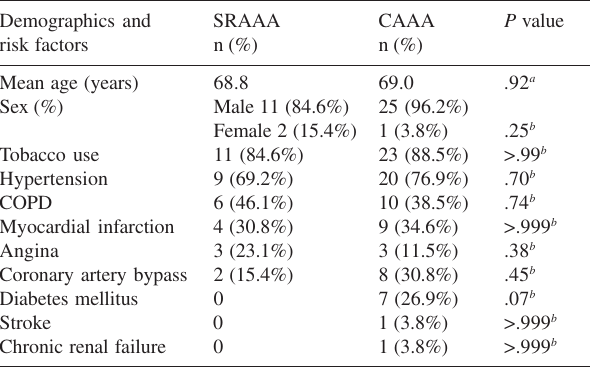
Table 1 - Demographics and risk factors for 13 patients with sealed rupture AAA (SRAAA) and 26 controls (CAAA) Demographics and